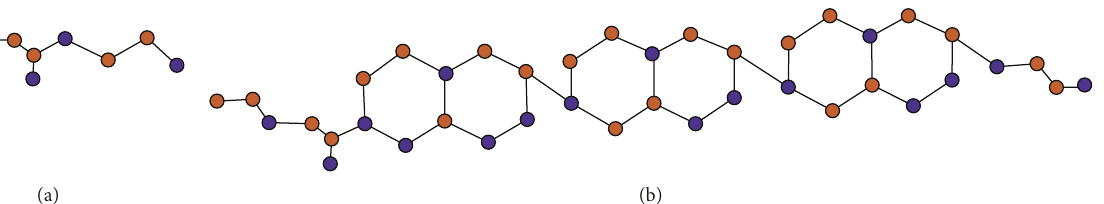
Figure 6: The unit cell and Si